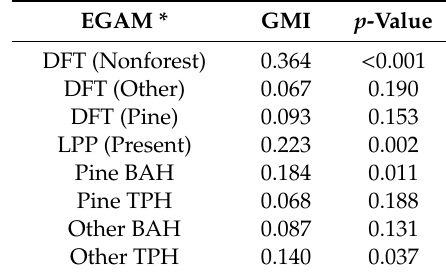
Figure 9. Predicted versus observed values (blue circles) of basal area per ha (BAH) and trees per ha (TPH) for pine and other tree species groups derived from ensemble generalized additive models (EGAMs) that used normalized predictors. The black dashed line shows the general trend based on a loess smooth estimator with grey shaded 95 percent confidence bands. The red line denotes a one to one line. Table 4. Global Moran’s I (GMI) statistics and p -values for the hypothesis of no spatial association for ensemble generalized additive model (EGAM) residuals.